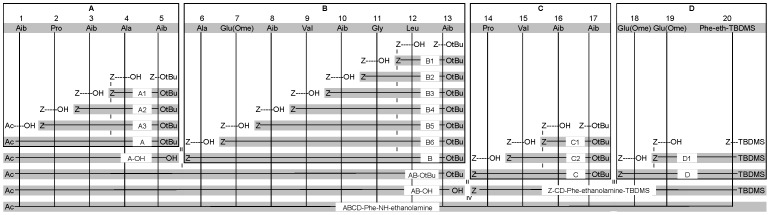
Synthetic strategy for the synthesis of ABCD-ethanolamine with Z = Cbz.(i) Cbz-removal with H2, Pd-C and MeOH followed by coupling via EDC/HOAt. (ii) OtBu-removal with ZnBr2 .iii) OtBu-removal of the C-component with TFA/CH2Cl2 and Cbz-removal of the N-component with H2, Pd-C and MeOH, followed by the coupling via EDC/HOAt. (iv) Cbz-removal with H2, Pd-C and MeOH followed by coupling via PyBOP, followed by deprotection using TBAF.